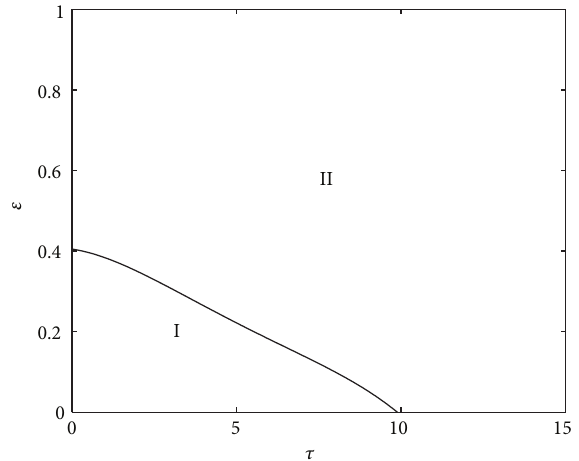
Figure 4: Regions of pattern structures of systems (1a) and (1b) with respect to noise intensity and temporal correlation for ] = 0 . I: no patch invasion; II: patch invasion.